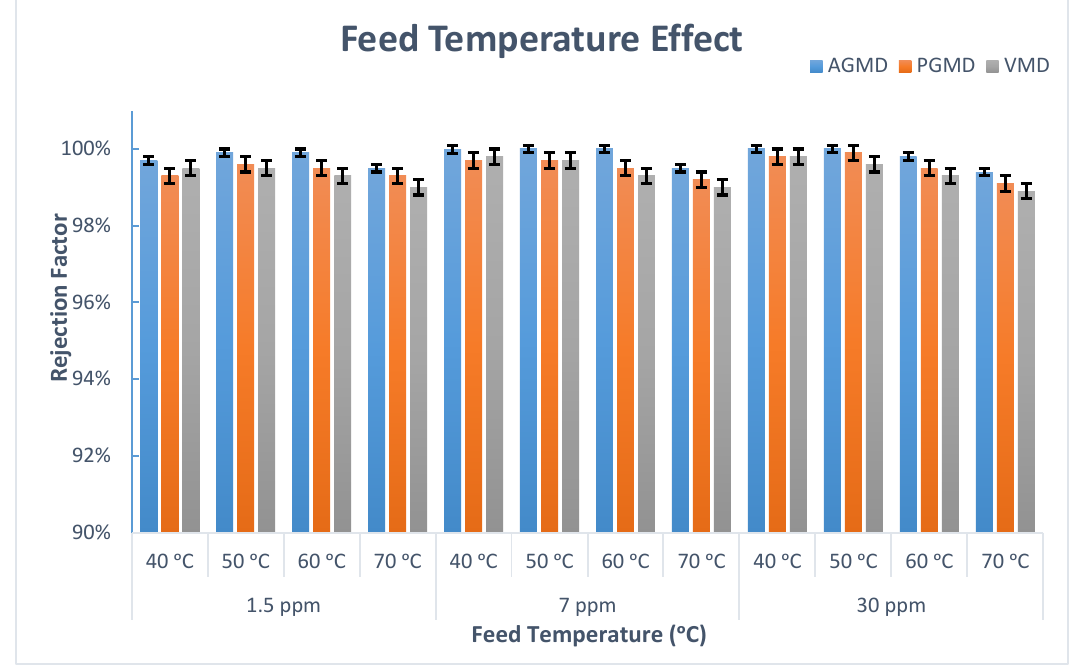
Figure 5. Boron rejection for AGMD, PGMD, and VMD at different feed temperatures and initial boron concentrations.